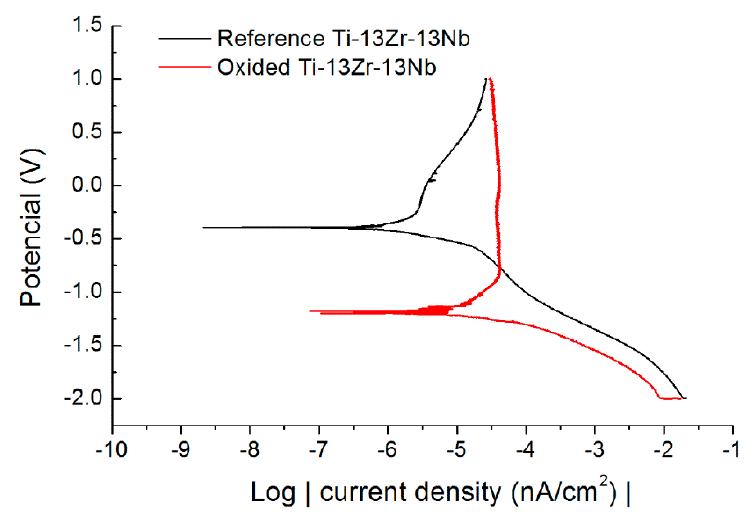
Figure 5. Potentiodynamic polarization curve of reference and oxidized Ti-13Zr-13Nb specimens.